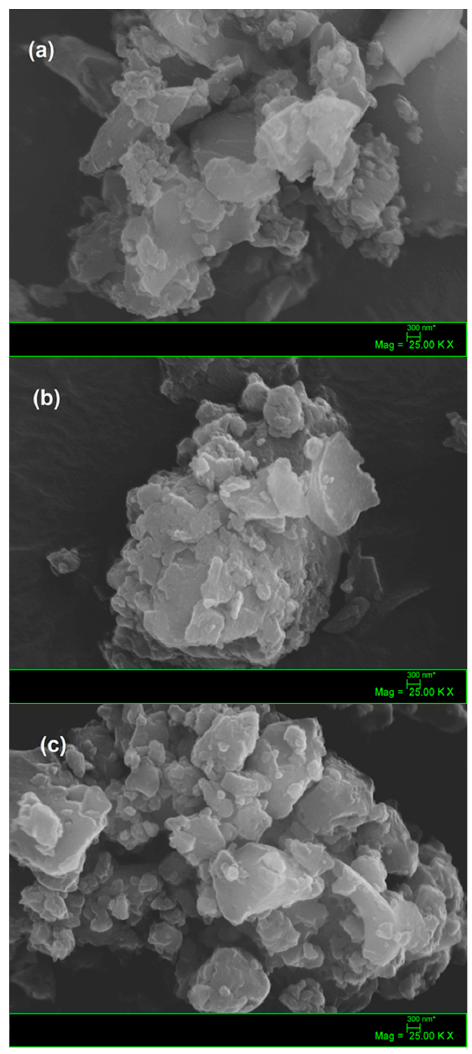
Figure 3. SEM images. ( a ) C-amorphous; ( b ) C/Zn; ( c ) C/ZnO/Zn.